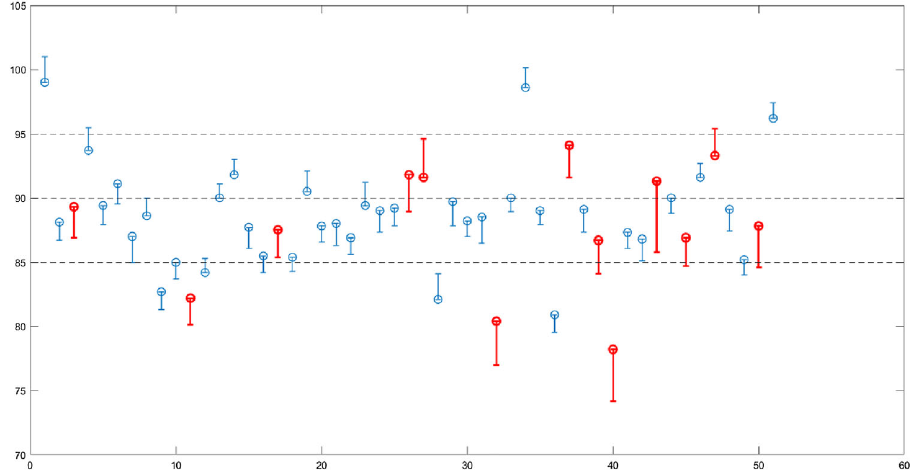
Fig. 8 The automatically detected utility pole angles and the angle differences between them and ground truth. The blue circles are 38 poles with angle differences between 1 (cid:5) and 2 (cid:5) and the red circles are 13 poles with angle differences larger than 2 (cid:5) . The vertical error bars indicate the angle differences between the automatically detected pole angles and the manually calculated pole